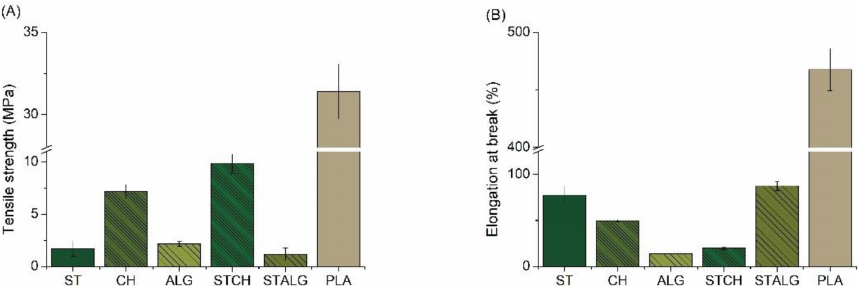
Figure 5. Tensile strength ( A ) and elongation at break ( B ) of the starch-based (ST), chitosan-based (CH), alginate-based (ALG), starch and chitosan-based (STCH) and starch and alginate-based (STALG) films and the commercially available PLA-based film ( p <